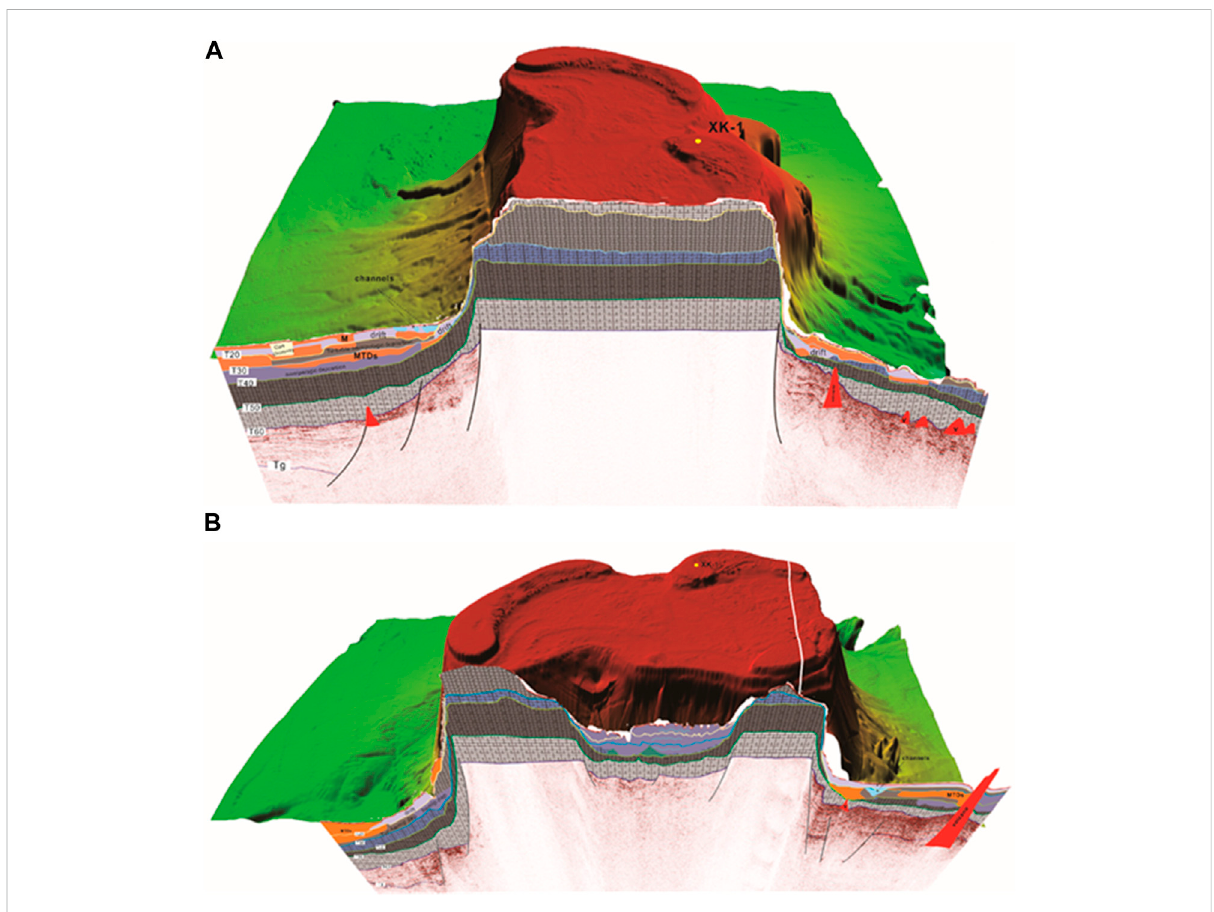
Asymmetric developmentoftheXuandeisolatedcarbonateplatformdeterminedfromseismicimaging. (A) E – Wsedimentarymodelacrossthe entire atoll. (B) N – S sedimentary model across the western margin of the